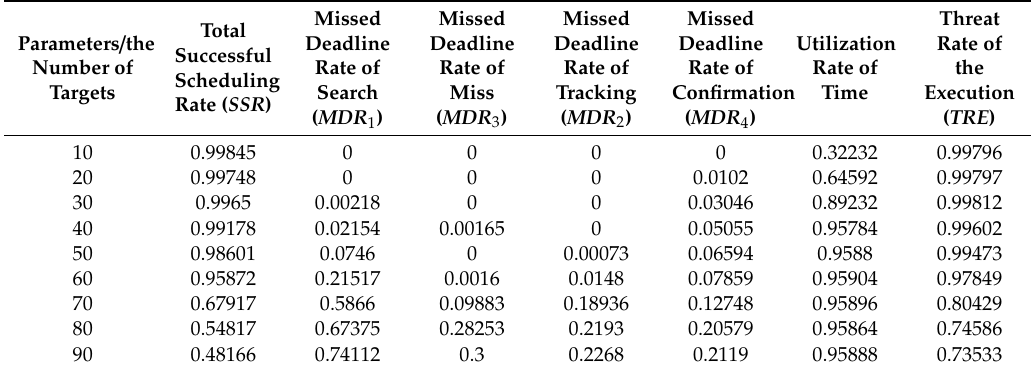
Table 3. Performance parameters of HiPrEDF.